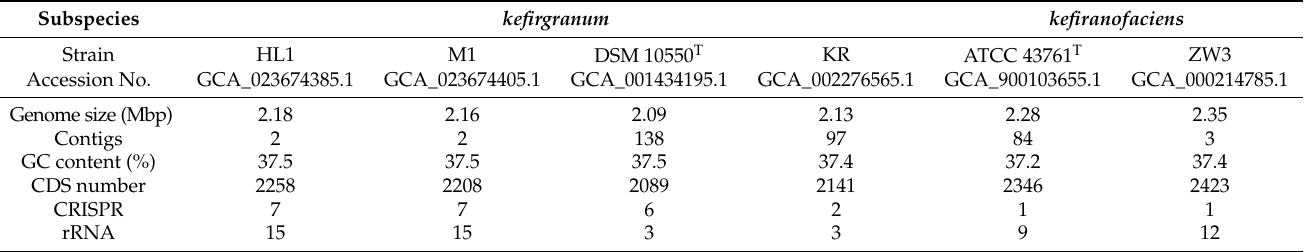
Table 2. General genomic features of Lactobacillus kefiranofaciens strains.